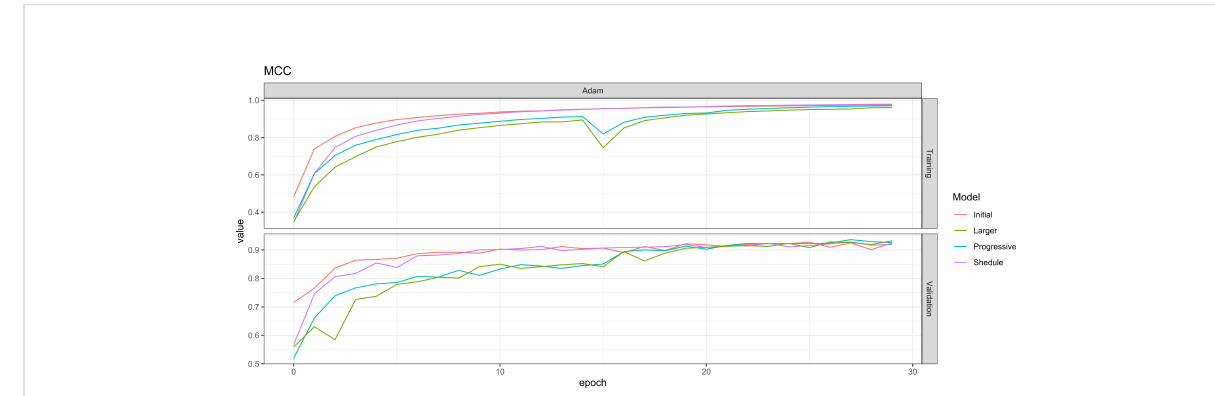
FIGURE 2 Matthews correlation coef fi cient (MCC) for the best models. MCC increases with the initial model, the model with learning rate scheduler, the model with progressive training and the larger model across the training process in the training as well as in the validation set. Models which used progressive learning show a drop at epoch 15 which corresponds to the changing hyperparameter settings at this point of time. MCC, Matthews correlation coef fi